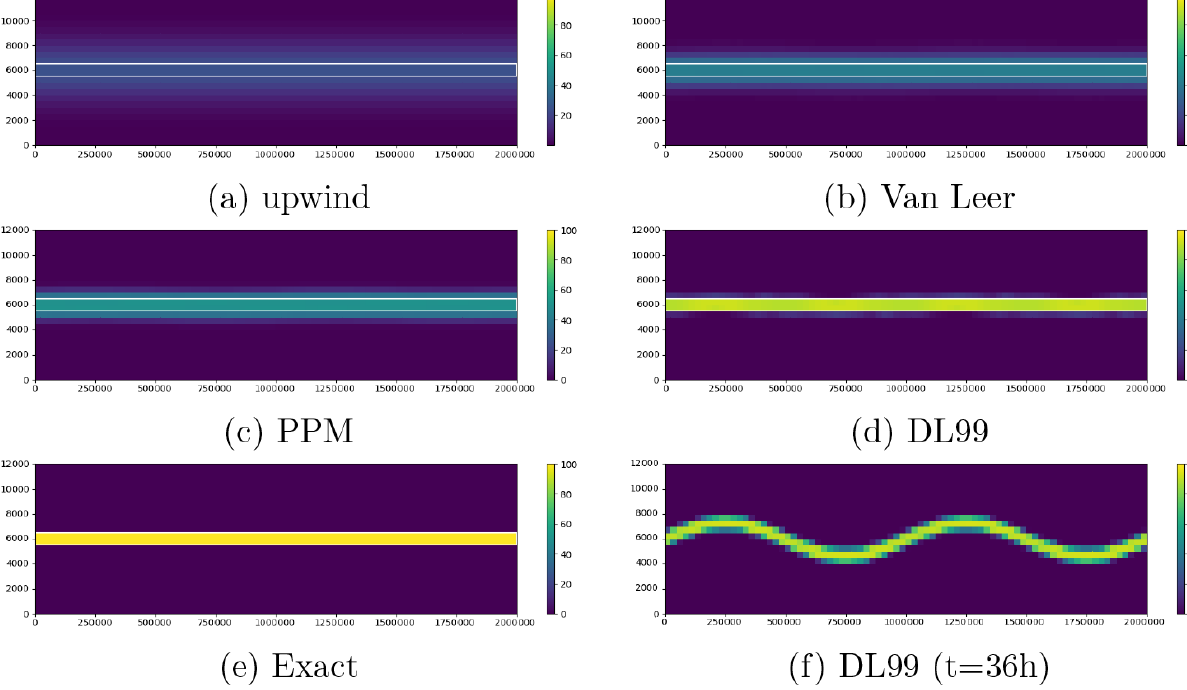
Figure 2. Final state of the numerical simulation for Case 2 after simulations. Panels (a–d) show the results obtained with Upwind, VL, PPM and DL99, respectively; (e) represents the exact solution (which is strictly equal to the initial state due to periodicity in time of the case); and (f) represents the state of the DL99 simulation after 36h simulation.